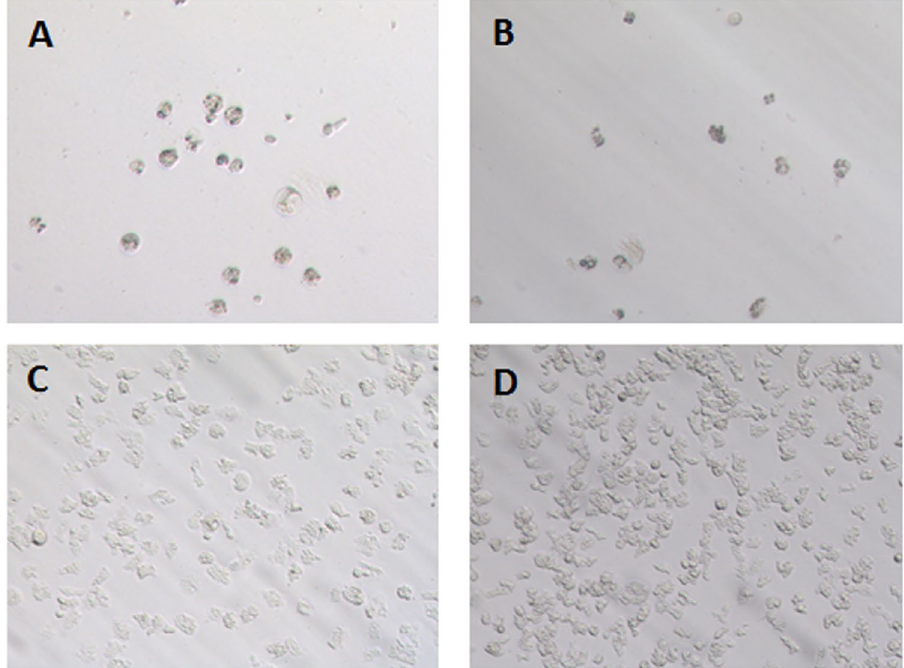
Figure 1. Effect of Systane Ultra at 12.5% against Acanthamoeba castellanii Neff ( A ) and and A . griffini strain ( B ) trophozoites observed by inverted microscopy (x20). Negative control (untreated strains) Acanthamoeba castellanii . Neff ( C ) and A . griffini ( D ), at 96 hours of incubation respectively.